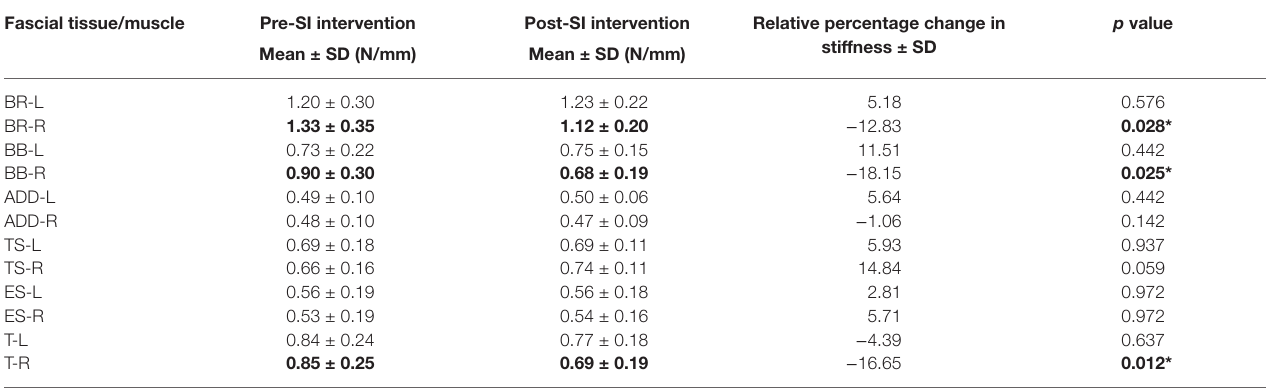
TABLE 3 | The intragroup analysis of the stiffness results. Fascial tissue/muscle